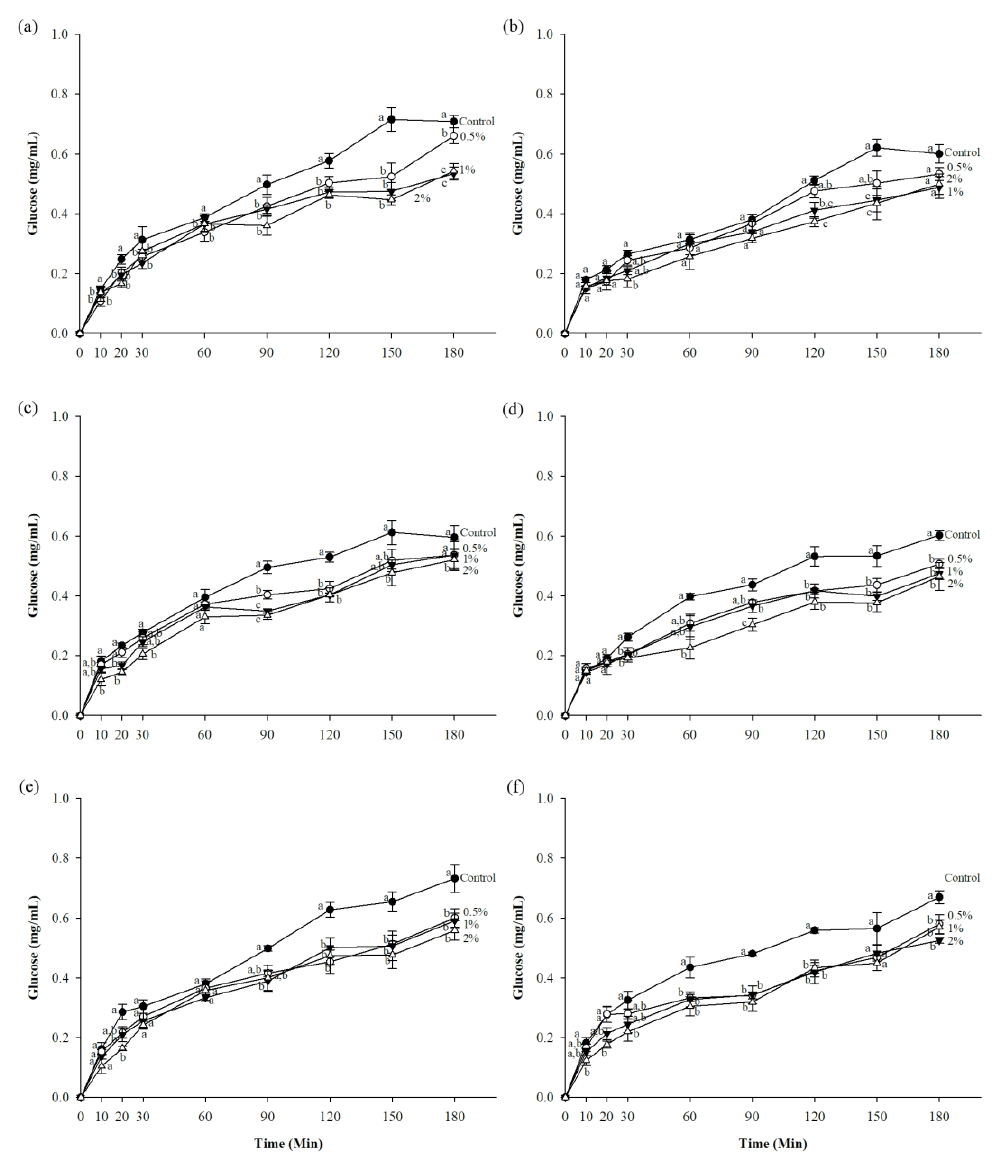
Figure 2. The amount of glucose released from ( a ) potato flour, ( b ) rice flour, ( c ) glutinous rice flour, ( d ) wheat flour, ( e ) corn flour, and ( f ) cassava flour when in combination with the different concentrations of CTE under in vitro digestibility during 180 min. The value of 0.5%, 1%, and 2% ( w / v ) represent the concentration of CTE, respectively. The results are expressed as mean ± standard error of the mean (SEM), n = 4. The different letters denote statistically significant differences in mean values. ( p < 0.05) Mean values with the same superscript letters (a, b or c) were similar and no statistically significant differences were observed for these samples.